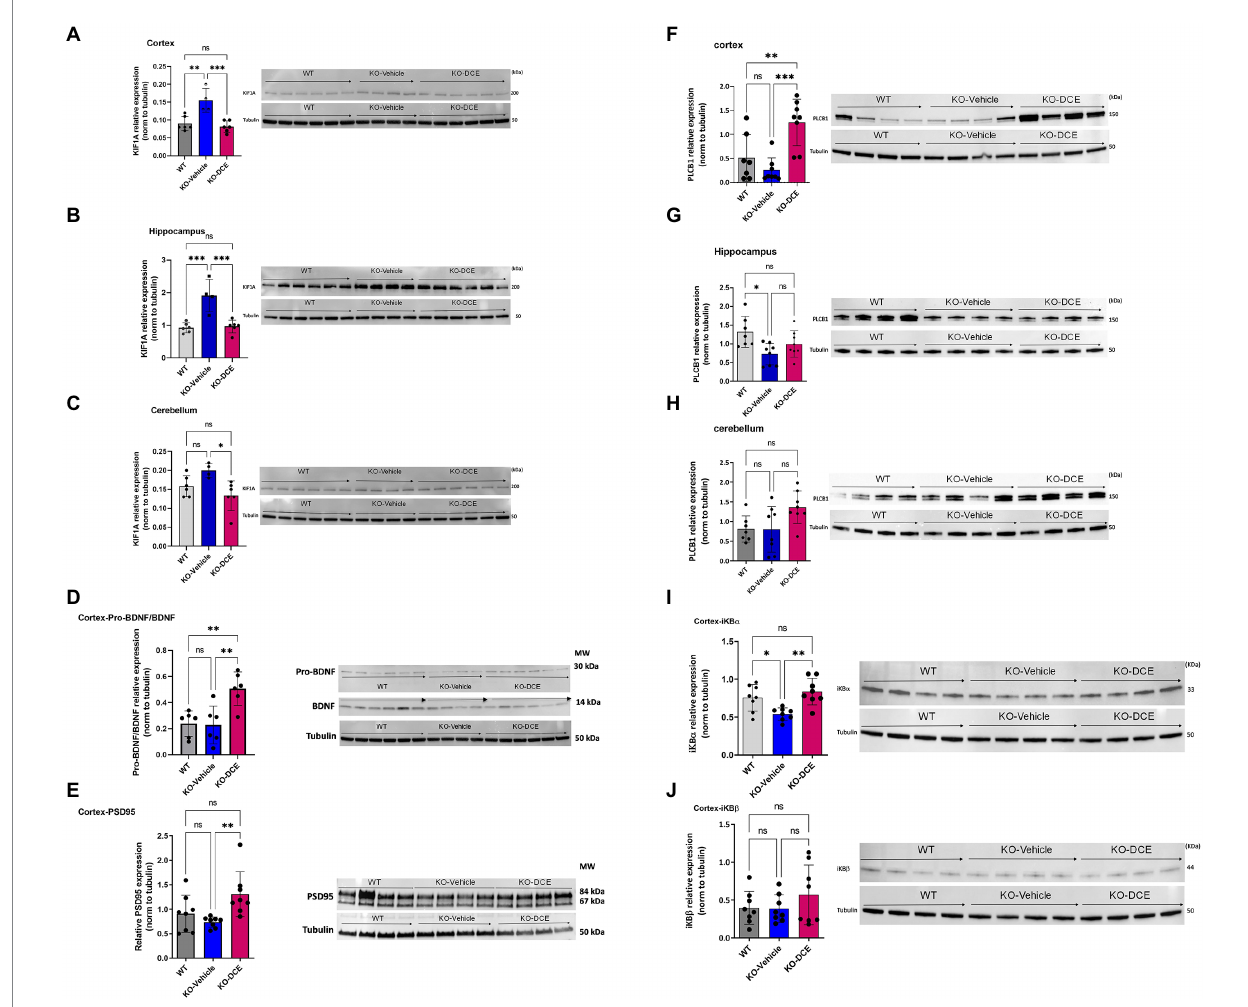
FIGURE 4 KIF1A and PLCB1 interplay is associated with DCE treatment efficacy in CrT Ko mice. (A–C) Western blot results showing that the KIF1A level was significantly increased in the cortex (A) , hippocampus (B) and cerebellum (C) in vehicle-treated CrT KO mice compared to WT mice, while DCE treatment rescued this overabundance in the three brain regions in CrT KO mice. (D, E) Western blot results showing that the pro-BDNF/BDNF ratio (D) was significantly altered in DCE-treated CrT KO mice compared to that of both WT mice and vehicle-treated CrT KO mice. In addition, the PSD95 level (E) was significantly altered in the cortices of vehicle-treated CrT KO mice compared to that of DCE-treated CrT KO mice. (F–H) , Western blotting showed that PLCB1 protein (150 kDa) abundance was increased in the cortex (F) , hippocampus (G) and cerebellum (H) in CrT KO mice at 0 days after DCE treatment. (I,J) Western blot results for Ib α (I) and I κ B β (J) showing that DCE promotes I κ B α transcription factor abundance but not I κ B β transcription factor abundance. The data are the mean ± s.e.m. ( n = 8/group). Statistical analysis was performed by one-way ANOVA followed by Tukey’s post-hoc test. Tubulin was used as a loading control. * p ≤ 0.05; ** p ≤ 0.001; *** p ≤ 0.0001; ns = not